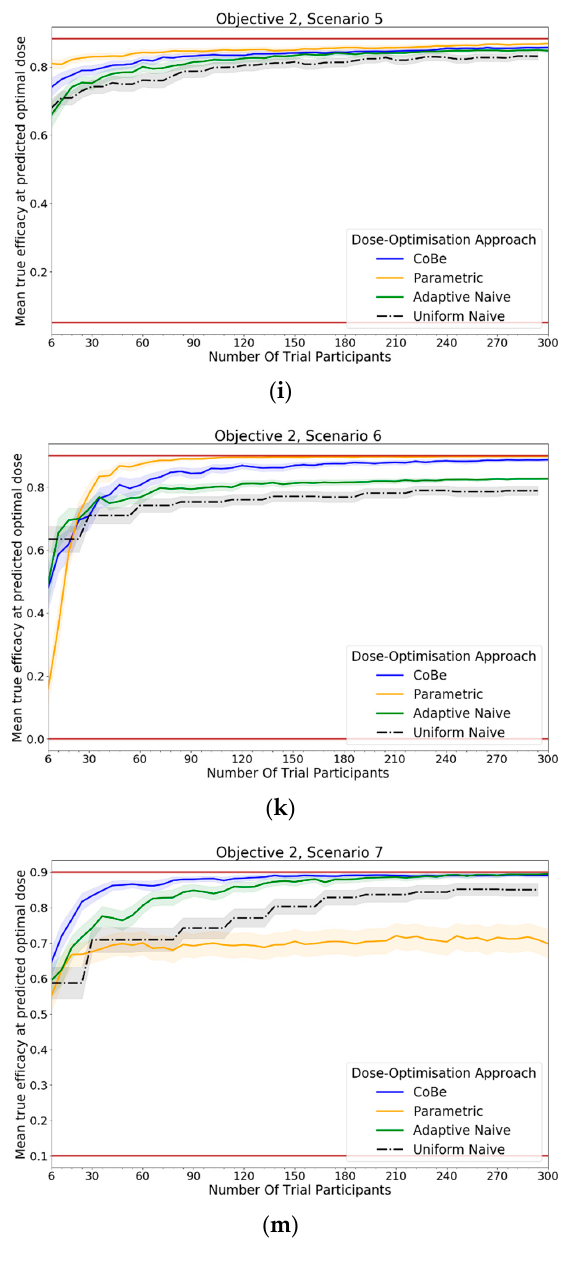
than the Parametric DOA for scenarios 2 and